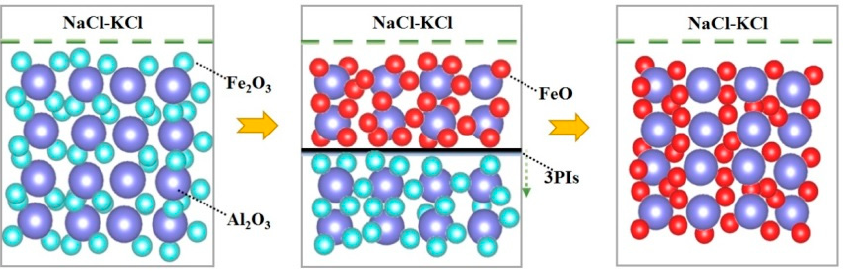
Figure 10. Schematic illustration of electrochemical process during the electro-reduction of Fe 2 O 3 /Al 2 O 3 .